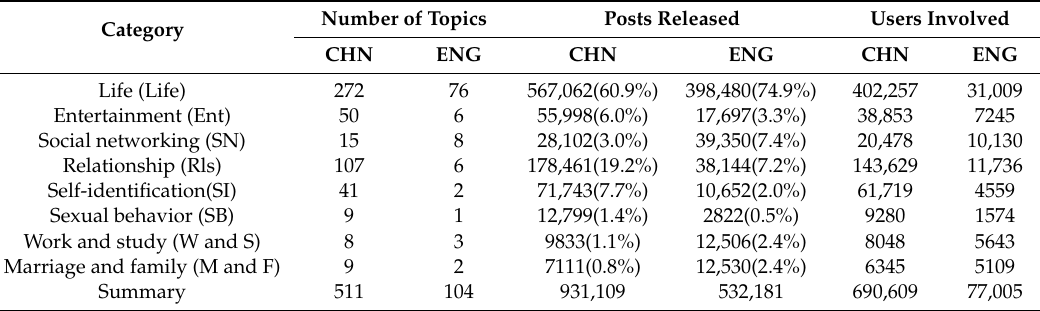
Table 3. The statistical results of topic